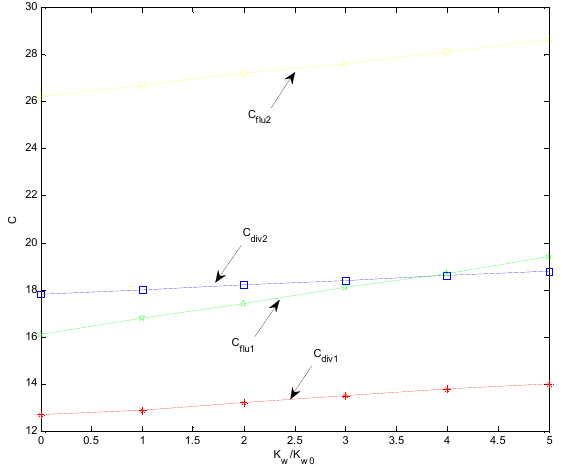
Figure 6. Effect of the Winkler’s modulus k w on the flutter and divergence speed of the axially-moving nanoplate.